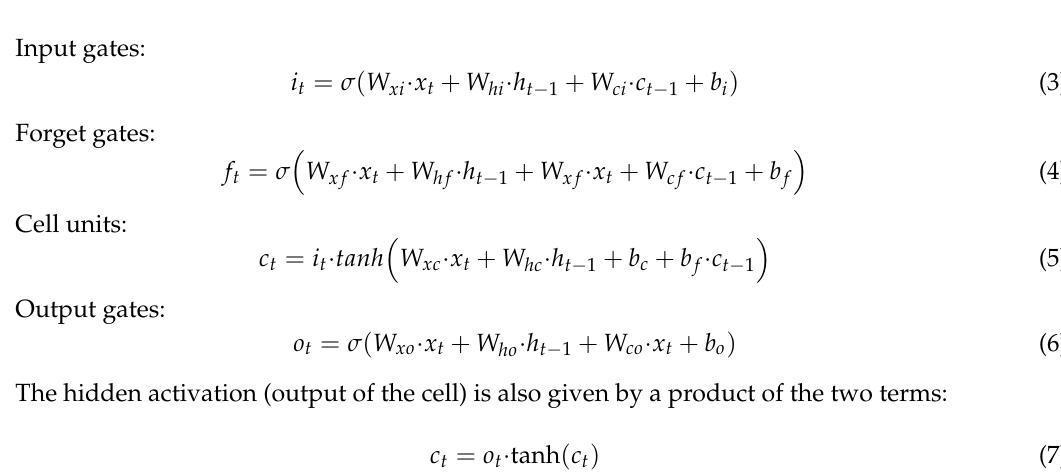
Figure 6. Architecture of the MLR ‐ NN model; GLCM: gray level co ‐ occurrence matrix, StdDev: standard deviation. 3.9.2. RNN RNN is a sequence problem considered as the addition of loops to architecture. For example, in any layer under consideration, signals can be passed to each neuron and are subsequently forwarded to the next layer. The network output can be input to the network in the next input feature, and so